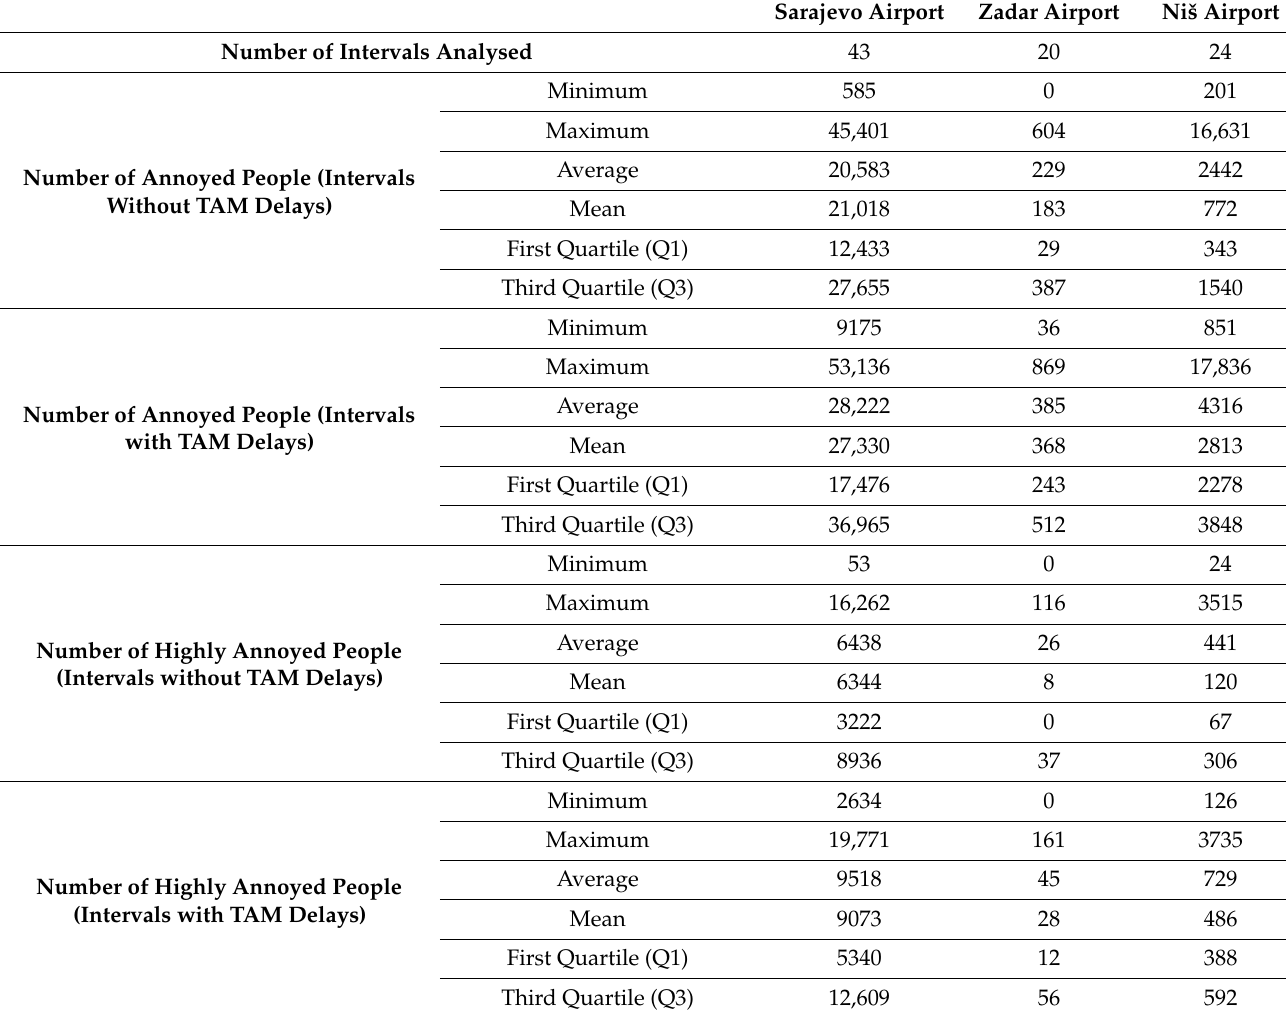
Table 1. Number of people annoyed and highly annoyed around the three airports. Sarajevo Airport Zadar